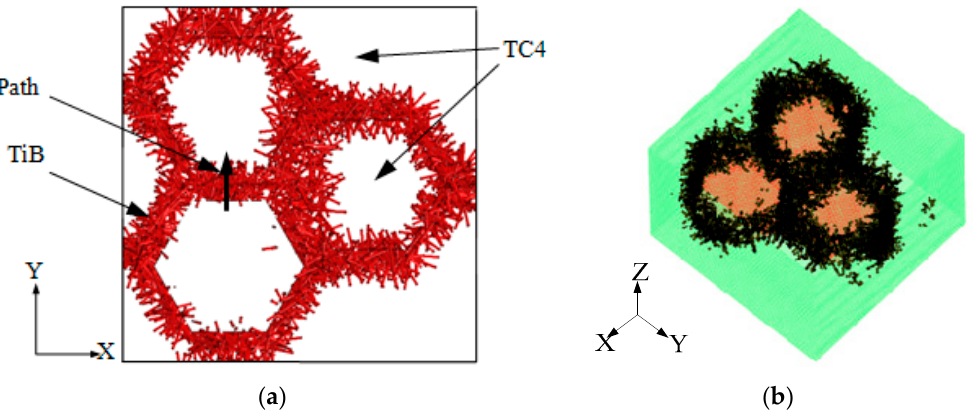
Figure 5. Three-dimensional model of TiBw/TC4 composite. ( a ) Representative elementary volume (RVE); and ( b ) network generation.